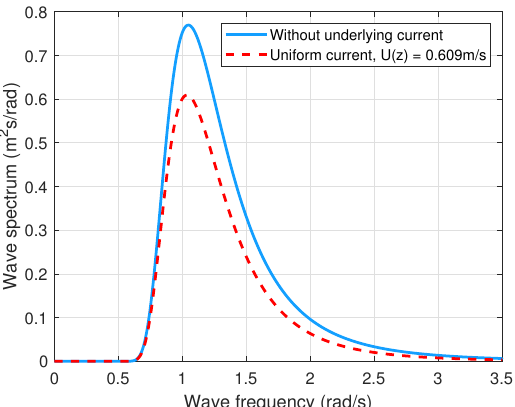
Figure 4. Pierson–Moskowitz spectrum with and without an underlying